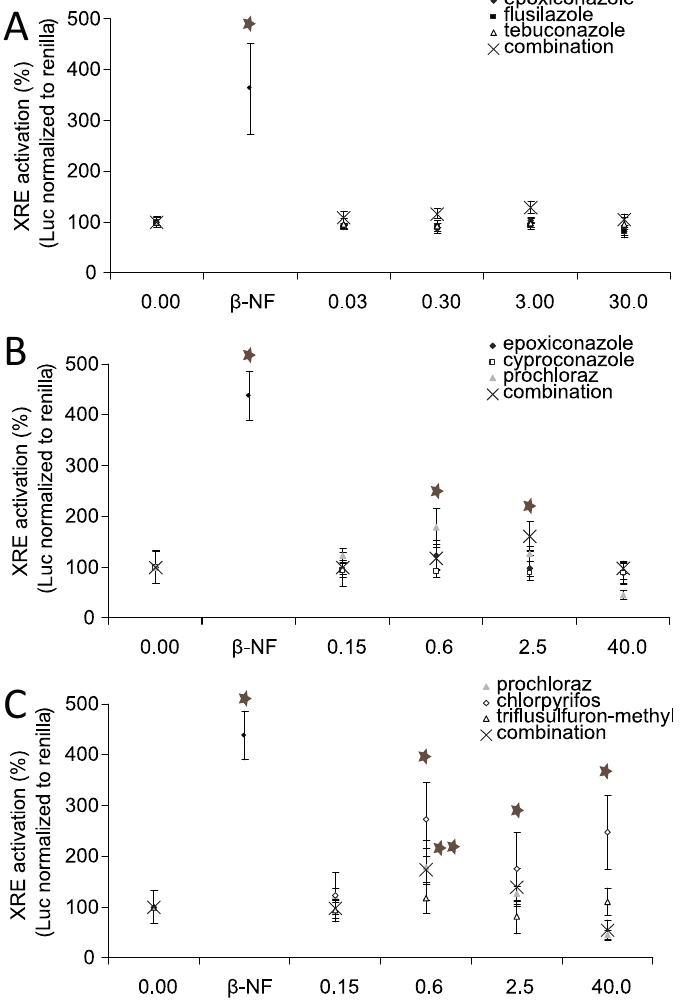
Figure 5. Substance effects on AhR transactivation. Jeg-3 cells were grown in 96-well cell culture plates for 24 h. Thereafter, the cells were transiently transfected with xenobiotic response element (XRE) luciferase reporter gene and renilla reporter gene (40:1) and TransIT-2020 in a ratio 1:3 for 20 h. Finally, the cells were incubated with the substances individually and in combination in concentrations as indicated: ( A ) flusilazole, epoxiconazole and tebuconazole, ( B ) epoxiconazole, cyproconazole and prochloraz, ( C ) prochloraz, chlorpyrifos, triflusulfuron-methyl. Cells were lysed and luciferase activity was measured as indicated by the manufacturer. The data represent the mean ± SD for two independent experiments ( n = 6). Concentration values given for combination treatments reflect total concentrations for all three components. Concentrations are given in µM.